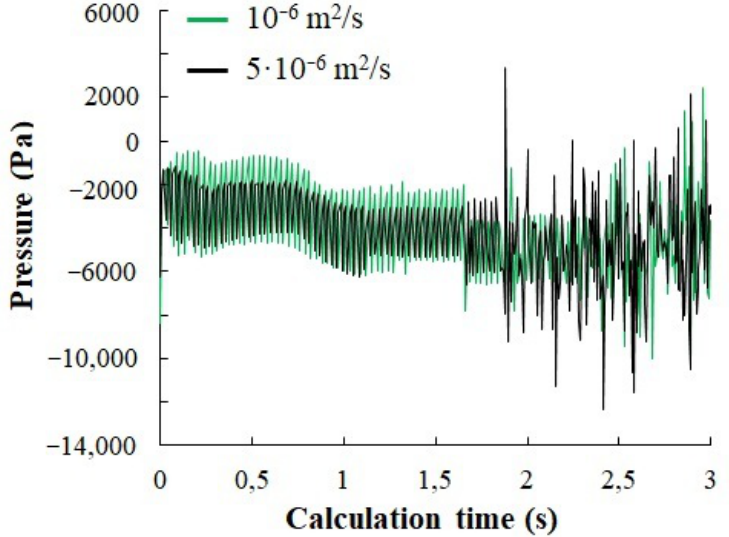
Figure 8. The dependence of pressure on time at different liquid viscosities at n = 1000 (rpm), h = 0.3 (m), L = 0.13 (m).